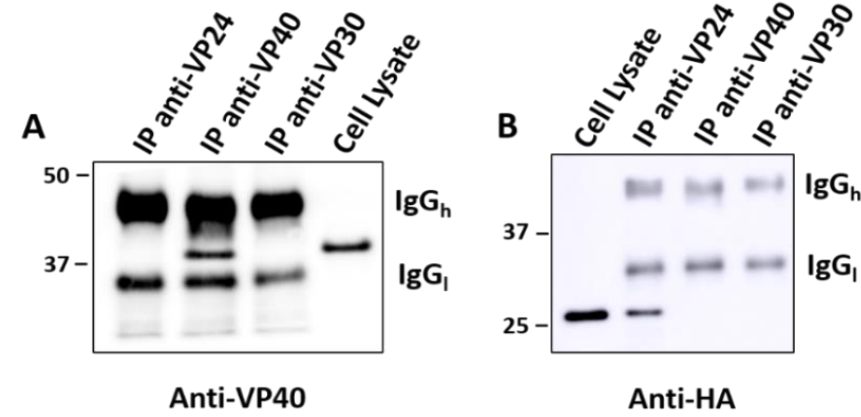
Figure 4. VP24 and VP40 did not interact as evidenced by co-immunoprecipitation (Co-IP). HEK 293 cells were transfected with both HA-VP24 and eVP40 plasmids. Co-IP was performed with anti-VP24, anti-VP40 or anti-VP30 as a control. VP40 and HA-VP24 in IPs were examined by anti-VP40 antibodies ( A ) and anti-HA antibodies ( B ), respectively. No VP24 or VP40 were detected in the IP of anti-VP30 antibodies. VP24 was detected in the IP of anti-VP24 but not in that of anti-VP40. Similarly, VP40 was detected in the IP of anti-VP40 but not in that of anti-VP24. Thus, VP24 and VP40 appear not to interact with each other in cell lysates. IgGh, antibody IgG heavy chain. IgGl, antibody lgG light chain.